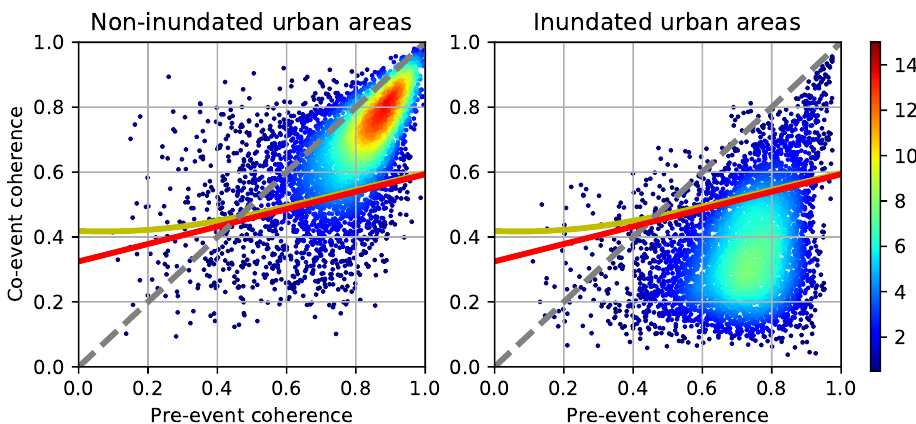
Figure 4. Feature samples collected during the 2019 Hagibis typhoon. The color marks depicts the density samples. The red and yellow solid lines denote the linear and non-linear discriminant functions calibrated using the SVM algorithm, respectively. The dashed line denotes the identity